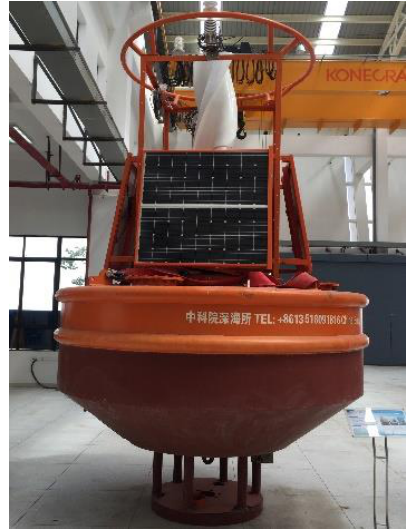
Figure 5. Mechanical Design of the Mooring Buoy.